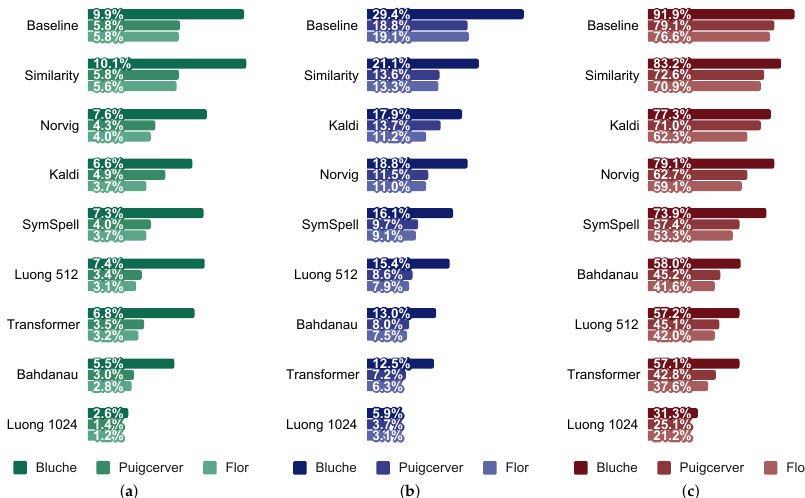
Figure 14. Error rates in the IAM dataset (lower is better), ( a ) Character Error Rate (CER); ( b ) Word Error Rate (WER); ( c ) Sequence Error Rate (SER).